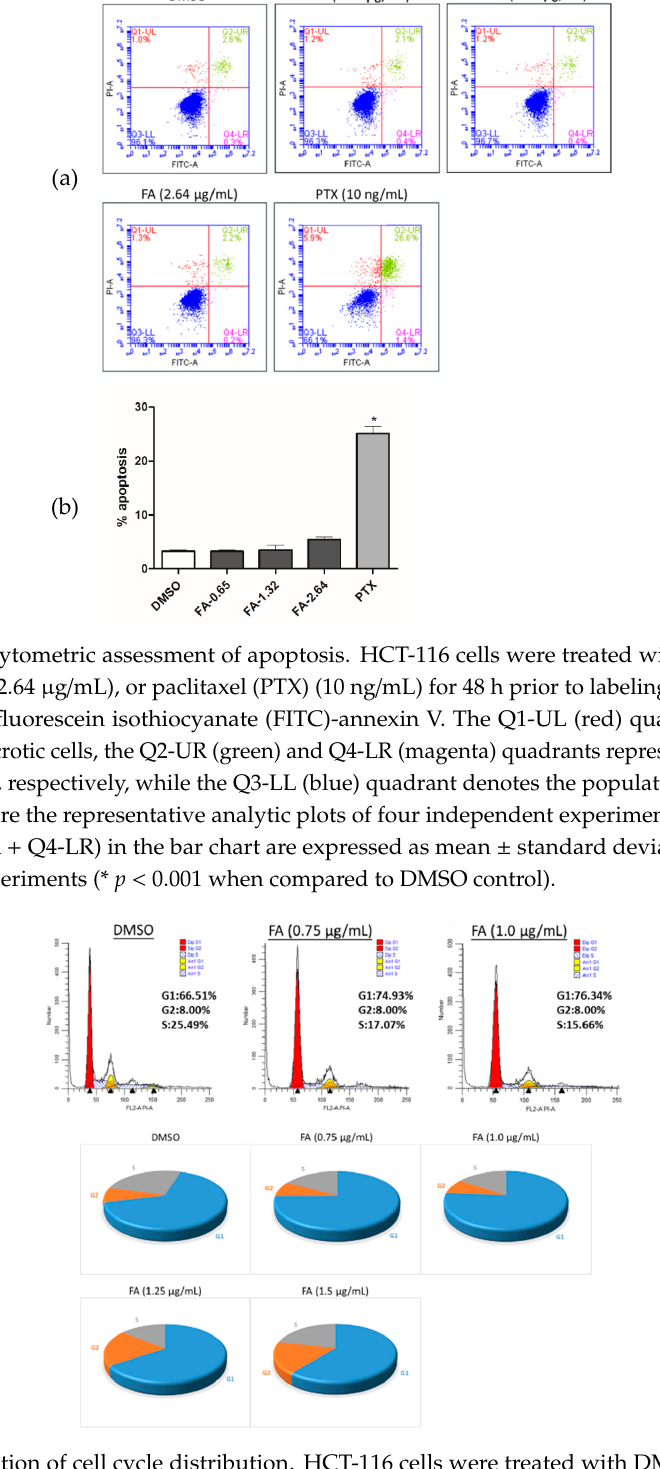
Figure 4. Evaluation of cell cycle distribution. HCT-116 cells were treated with DMSO (0.5%) or FA (0.75–1.5 µ g / mL) for 12 h prior to flow cytometric analysis. Shown here are representative distributions from three independent trials. In the pie charts, grey sections denote the S phase, blue sections denote the G1 phase, and orange sections denote the G2